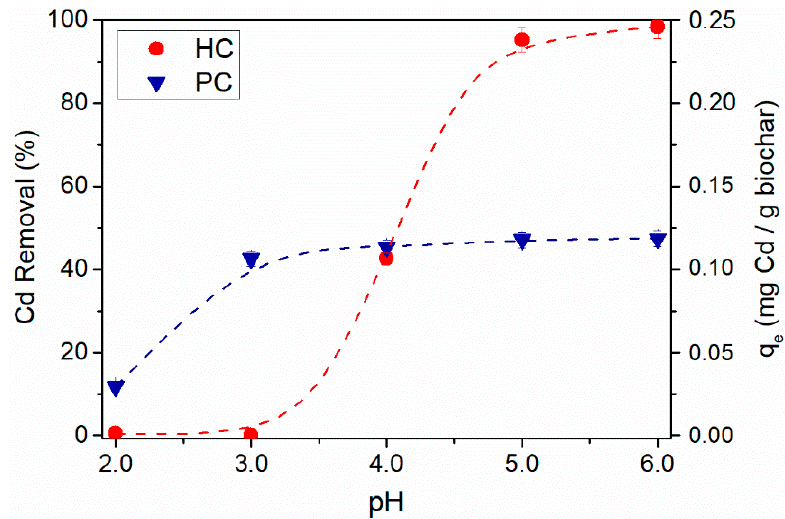
Figure 10. Effect of solution initial pH on Cd removal by HC and PC.